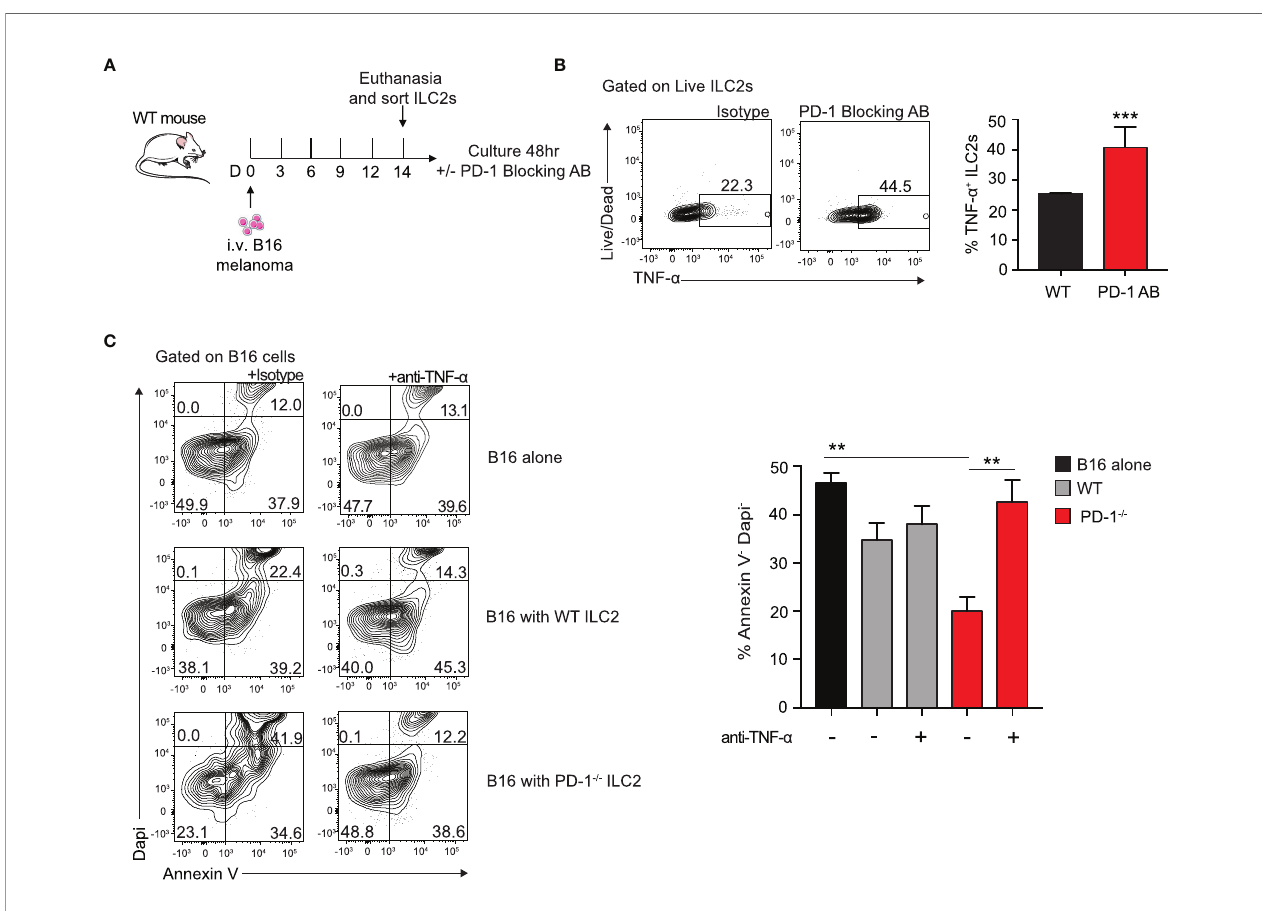
FIGURE 4 | Blocking PD-1 on ILC2s increases TNF- a production and enhances cytotoxic properties. (A) A cohort of WT mice was given an intravenous injection of B16 melanoma on day 0. On day 14 lung ILC2s were sorted by fl ow cytometry and cultured with isotype or PD-1 blocking antibody for 48 hours. (B) After 48 hours, ILC2 cells were harvested and measured for TNF- a expression by intracellular fl ow cytometry. Representative fl ow cytometry plots and corresponding quanti fi cation are presented as percent TNF- a + ILC2s. (C) B16 melanoma cells were cultured in the bottom well of 0.4 µm Transwell plate. PD-1 -/- or WT ILC2s were cultured in the top well insert at 8:1 ratio with B16 melanoma cells respectively for 48 hours. In the condition speci fi ed, anti-TNF- a or isotype (10µg/ml) was included in the bottom well of the culture. After 48 hours, B16 cells were collected and stained with apoptosis kit to assess viability. Representative fl ow cytometry plots and corresponding quanti fi cation are presented. Error bars are the mean±SEM. Data are representative of 3 individual experiments with n=5. Student ’ s t-test, **p<0.01,